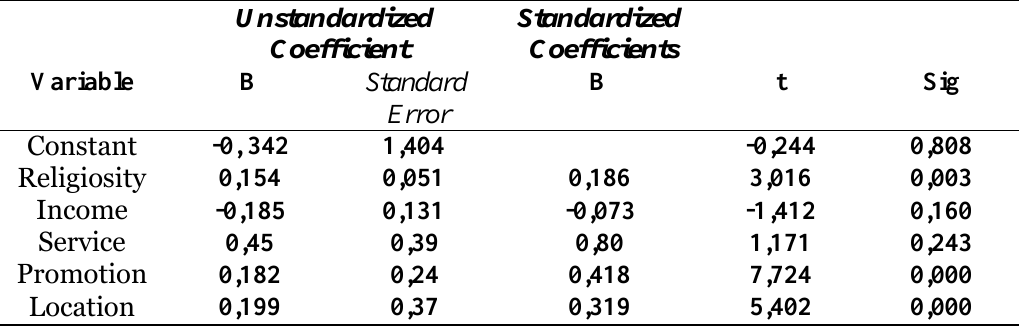
Multiple Linear Regression